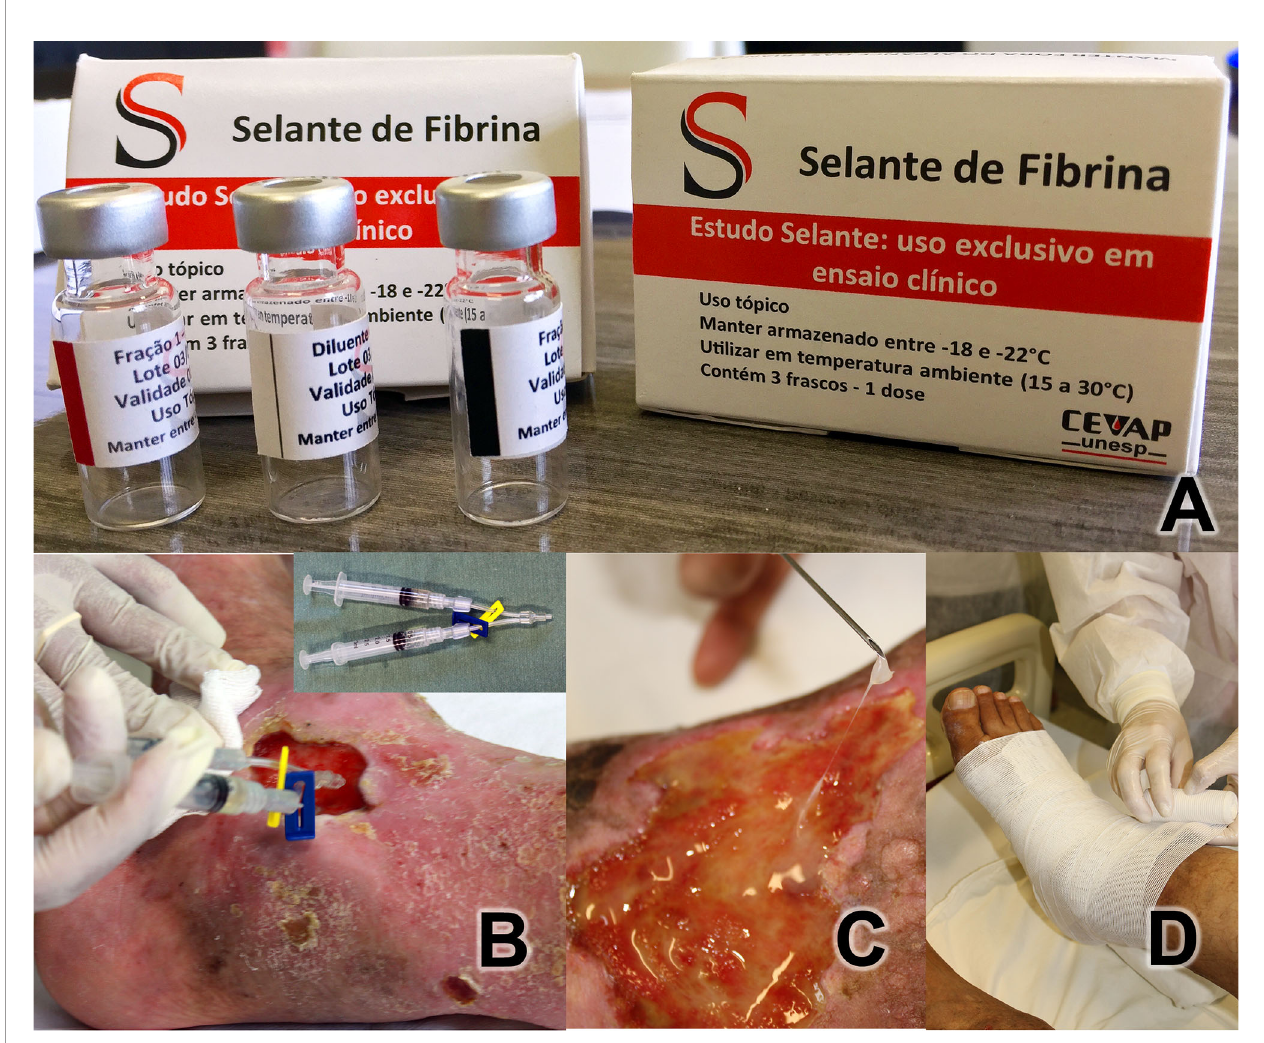
FIGURE 1 | (A) Heterologous Fibrin Sealant Package with the three bottles. Diluent vial (white stripe) containing 0.6 mL of calcium chloride; Fraction 1 vial (red stripe) containing 0.4 mL of serine protease extracted from the venom of Crotalus durissus terri fi cus ; Fraction 2 vial (black stripe) containing 1 mL of cryoprecipitate rich in fi brinogen and coagulation factors extracted from buffaloes. (B) Application investigational product on the ulcerated bed. Y-connector using two syringes (in detail) with 1 mL of components each one. (C) Detail of fi brin adhered to the ulcer. (D) After covering the ulcer bed with gauze soaked in essential fatty acids, the Unna boot was